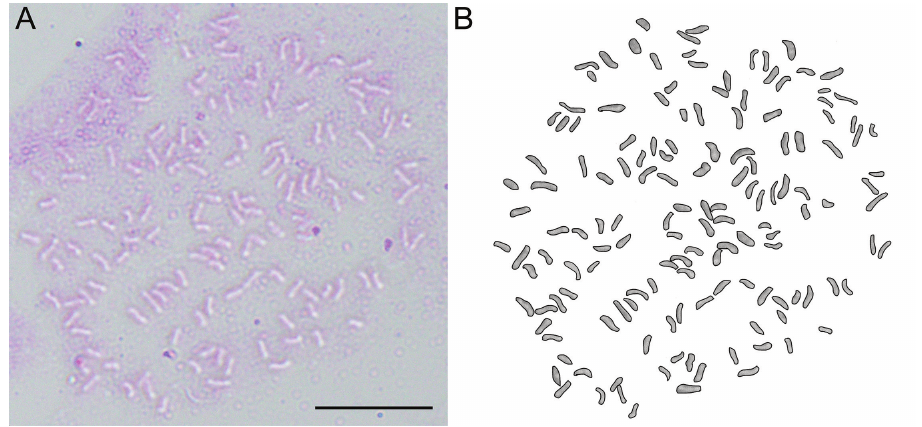
Figure 6. Chromosomes of Asplenium jiulianshanense K.W.Xu & G.L.Xu in mitotic root-tip cells, 2n = 144. Scale bars: 20